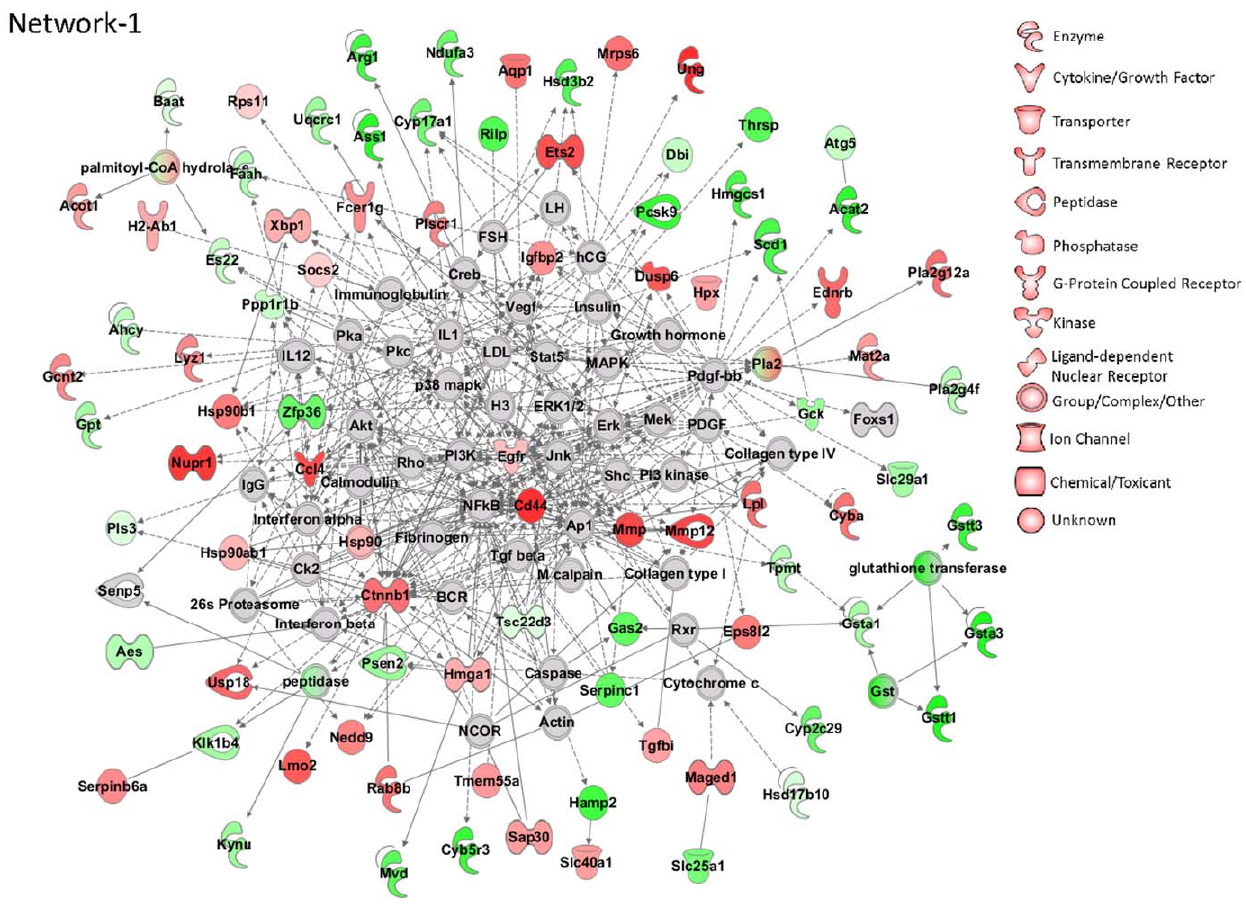
Figure 5. Top scoring network obtained from network analysis of differentially expressed genes. Ingenuity Pathway Analysis software was used to construct and visualize molecular interaction networks.